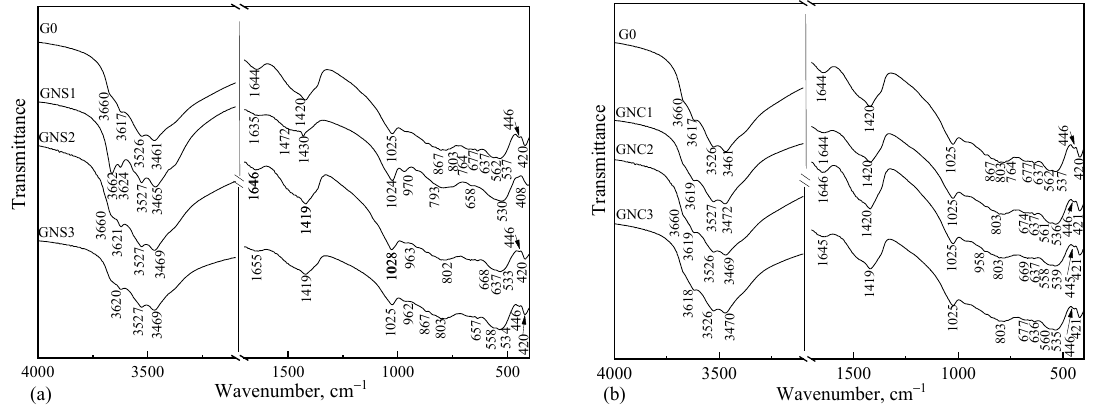
Figure 8. IR spectra of the hydrated CAC pastes without (G0) and with admixtures: NS ( a ) and NC ( b